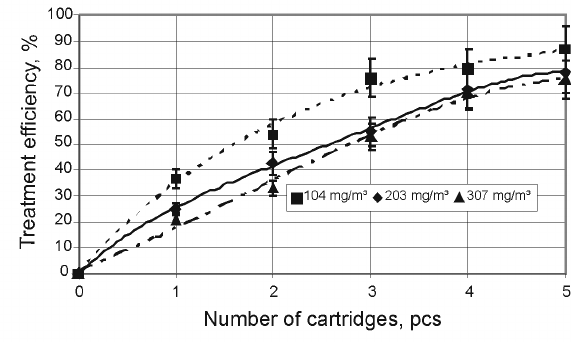
Fig. 7. Dependence of biofilter treatment efficiency on the number of cartridges when the original concentration of toluene is